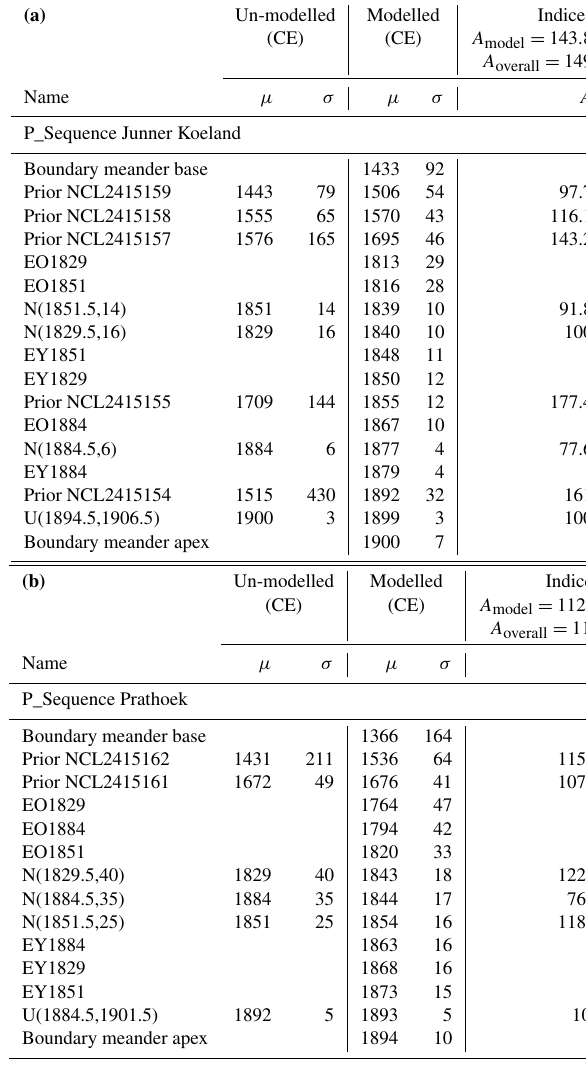
Table 4. Results of the Bayesian model for (a) Junner Koeland, iteration 4, and (b) Prathoek, iteration